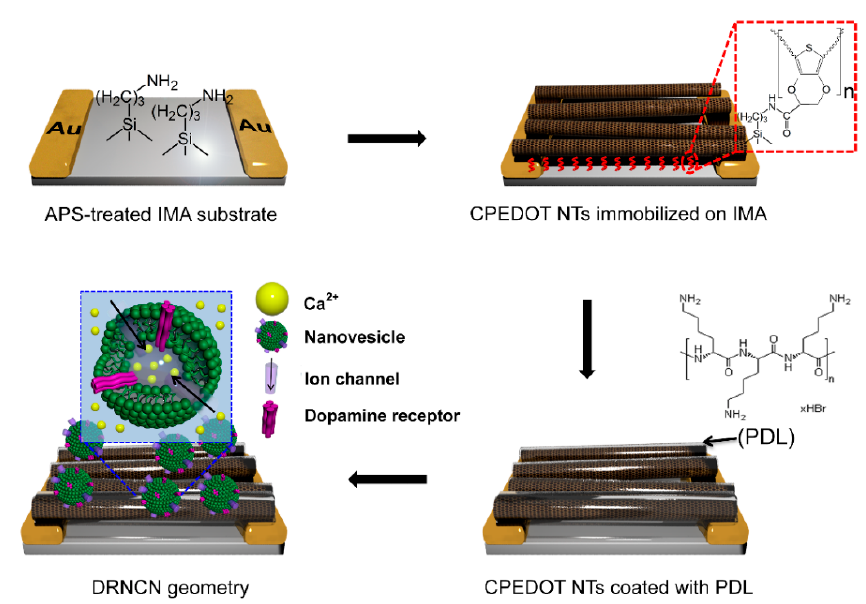
Figure 12. Schematic illustrations of construction steps for receptor geometry, where IMA, CPEDOT NTs, PDL, and DRNCN note interdigitated microelectrode array, carboxylated PEDOT nanotubes, poly- D -lysine, and dopamine receptor-containing nanovesicles-immobilized CPEDOT NTs, respectively. Reprinted with permission from [184]. Copyrights 2014, Nature Publishing Group.